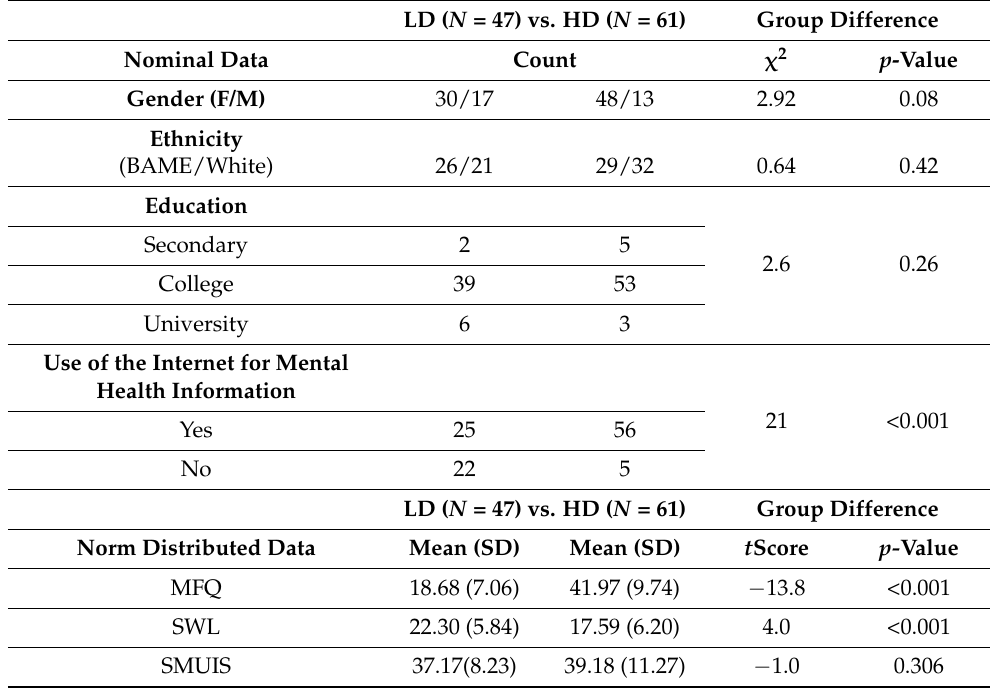
Table 3. Descriptive and inferential statistics for participants with low and high depression scores. LD ( N = 47) vs. HD ( N = 61)